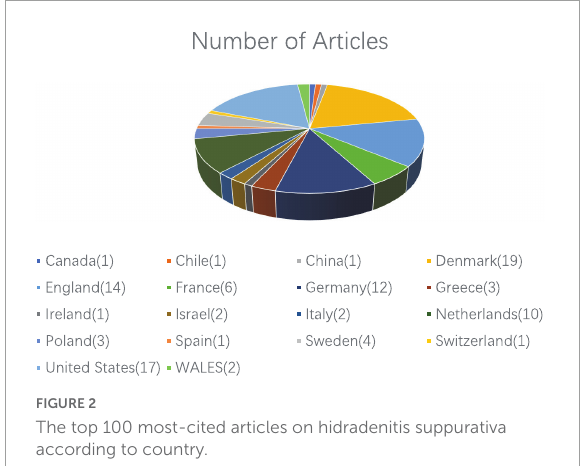
FIGURE2 The top 100 most-cited articles on hidradenitis suppurativa according to